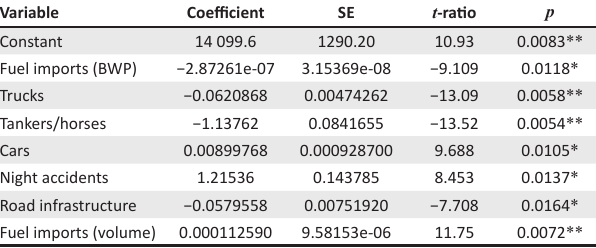
TABLE 2a: Accident count ordinary least squares